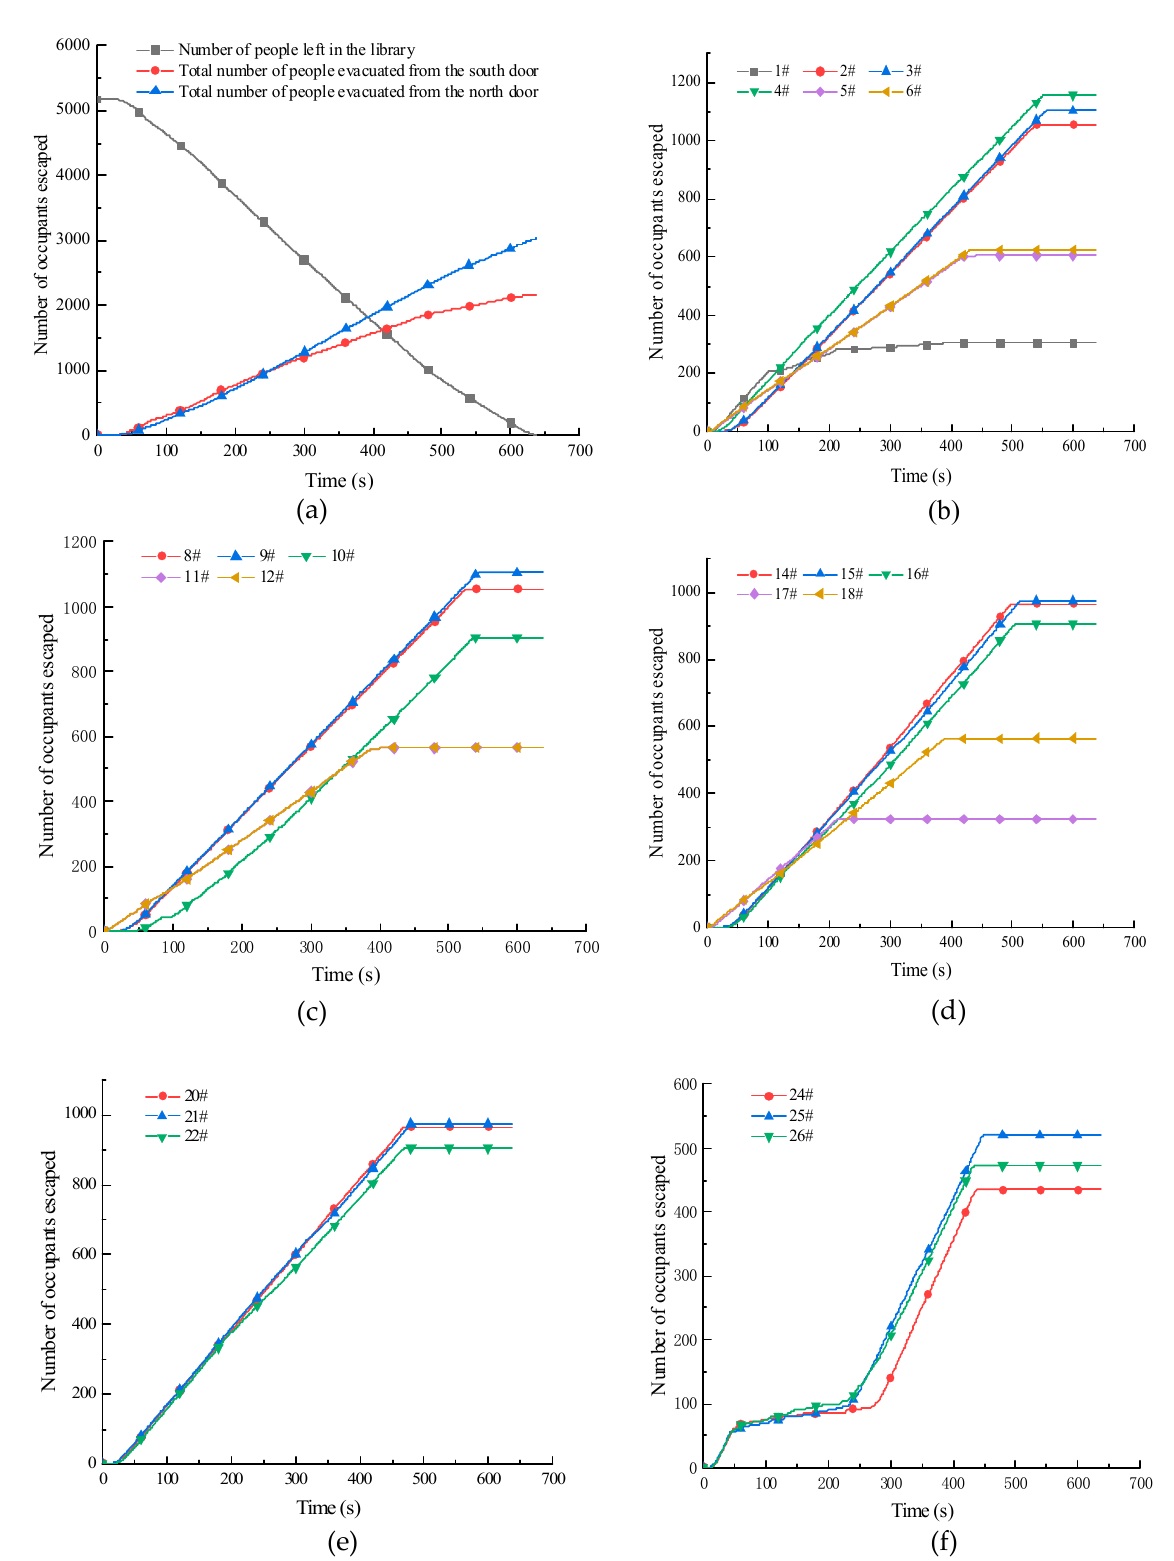
Figure 11. Evacuation of personnel at all levels after optimization. ( a ) Evacuation situation on 1 st Floor. ( b ) Evacuation situation on 2 nd Floor. ( c ) Evacuation situation on 3 rd Floor. ( d ) Evacuation situation on 4 th Floor. ( e ) Evacuation situation on 5 th Floor. ( f ) Evacuation situation on 6 th Floor. For channels 1#, 5#, 6#, 7#, 11#, 12#, 17 #, and 18# with fewer people, more people will